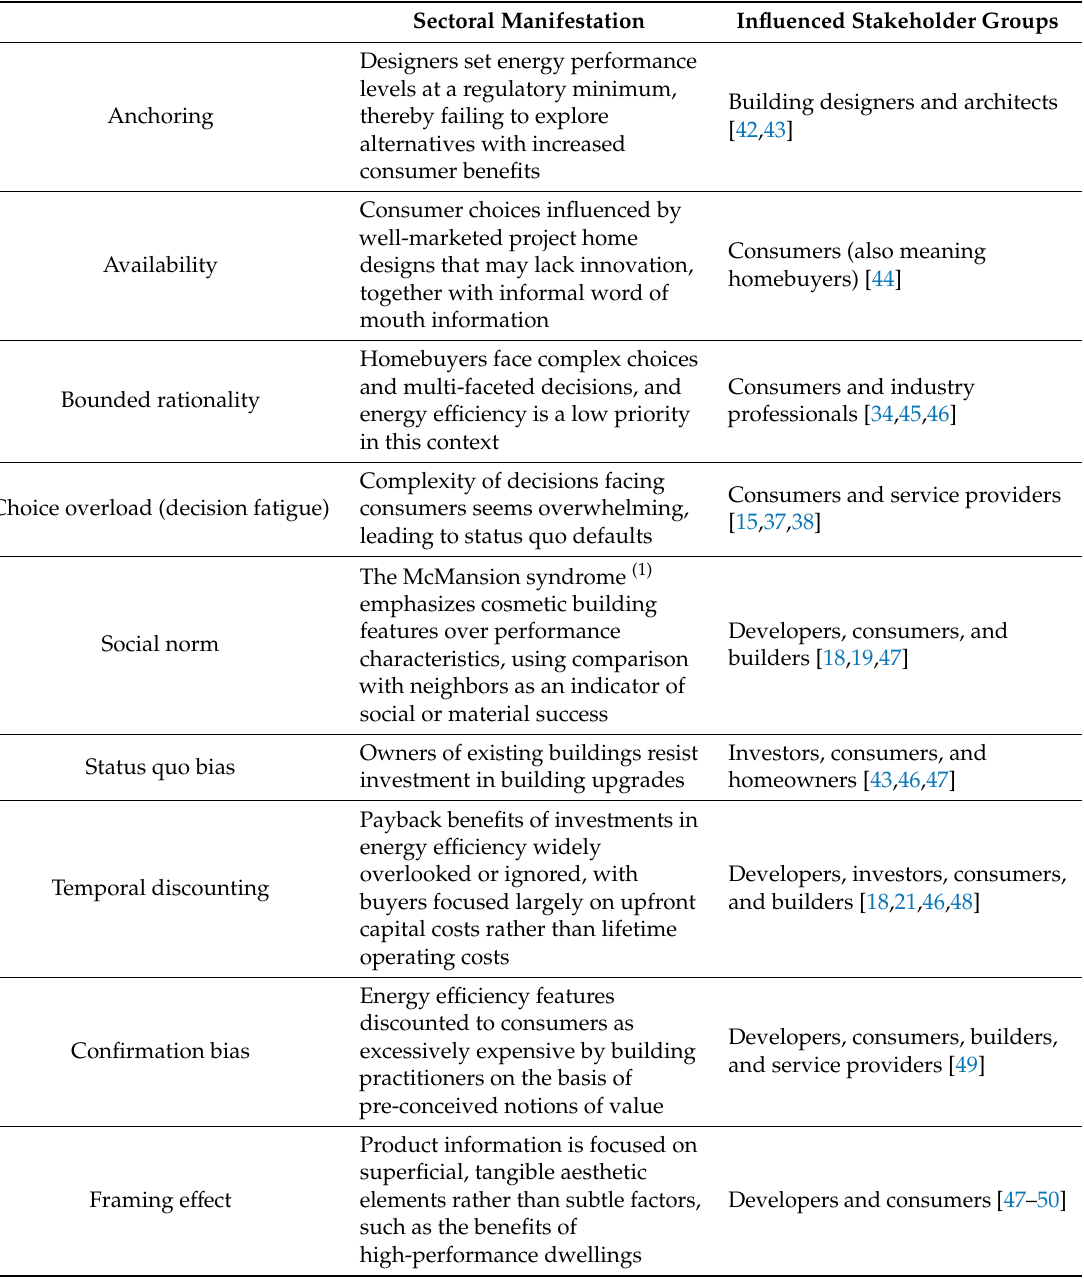
Table 3. Heuristics operating in the building sector defined in terms of a ff ected stakeholder groups amenable to interventions based on BE